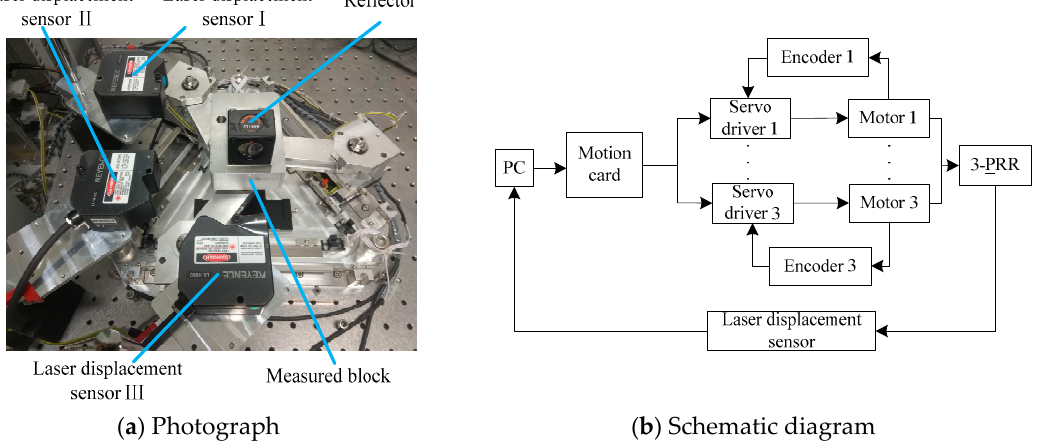
Figure 1. Photograph and schematic diagram of the closed-loop feedback control of the precision tracking system.